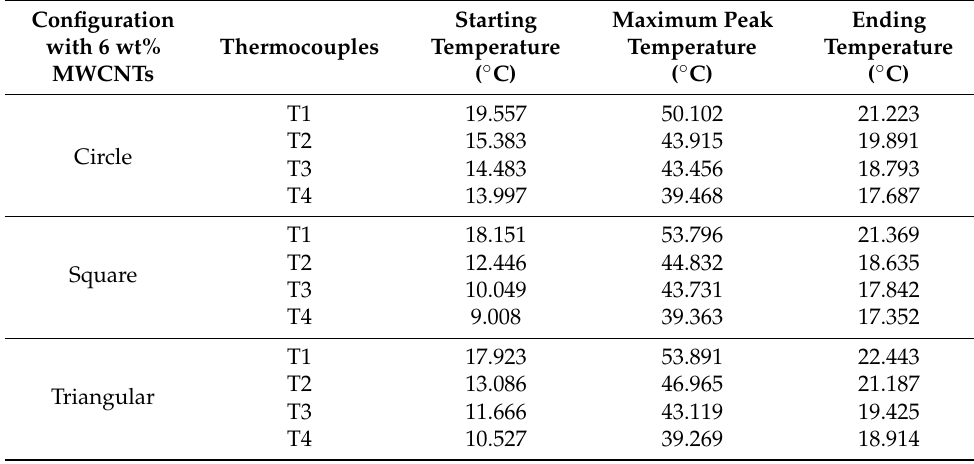
Table 6. Temperature data for configuration with 6 wt%